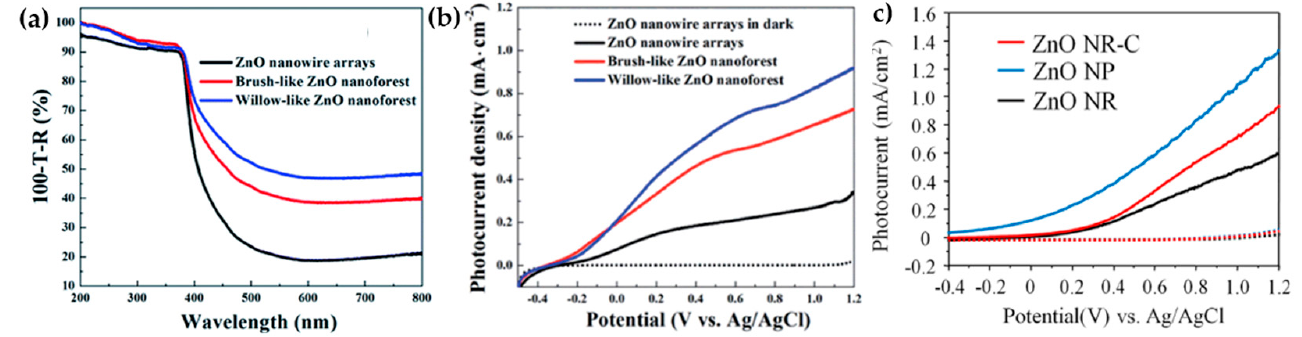
Figure 4. ( a ) Absorption spectra, and ( b ) linear sweep voltammograms (LSV) curve of the nanorod, nanoforest, and willow–like ZnO superstructures. Reprinted with permission from [20]. Copyright 2014 Royal Society of Chemistry. ( c ) Photocurrent density measurement of ZnO nanorod and nanopencil. Reprinted with permission from [16]. Copyright 2014 Elsevier.